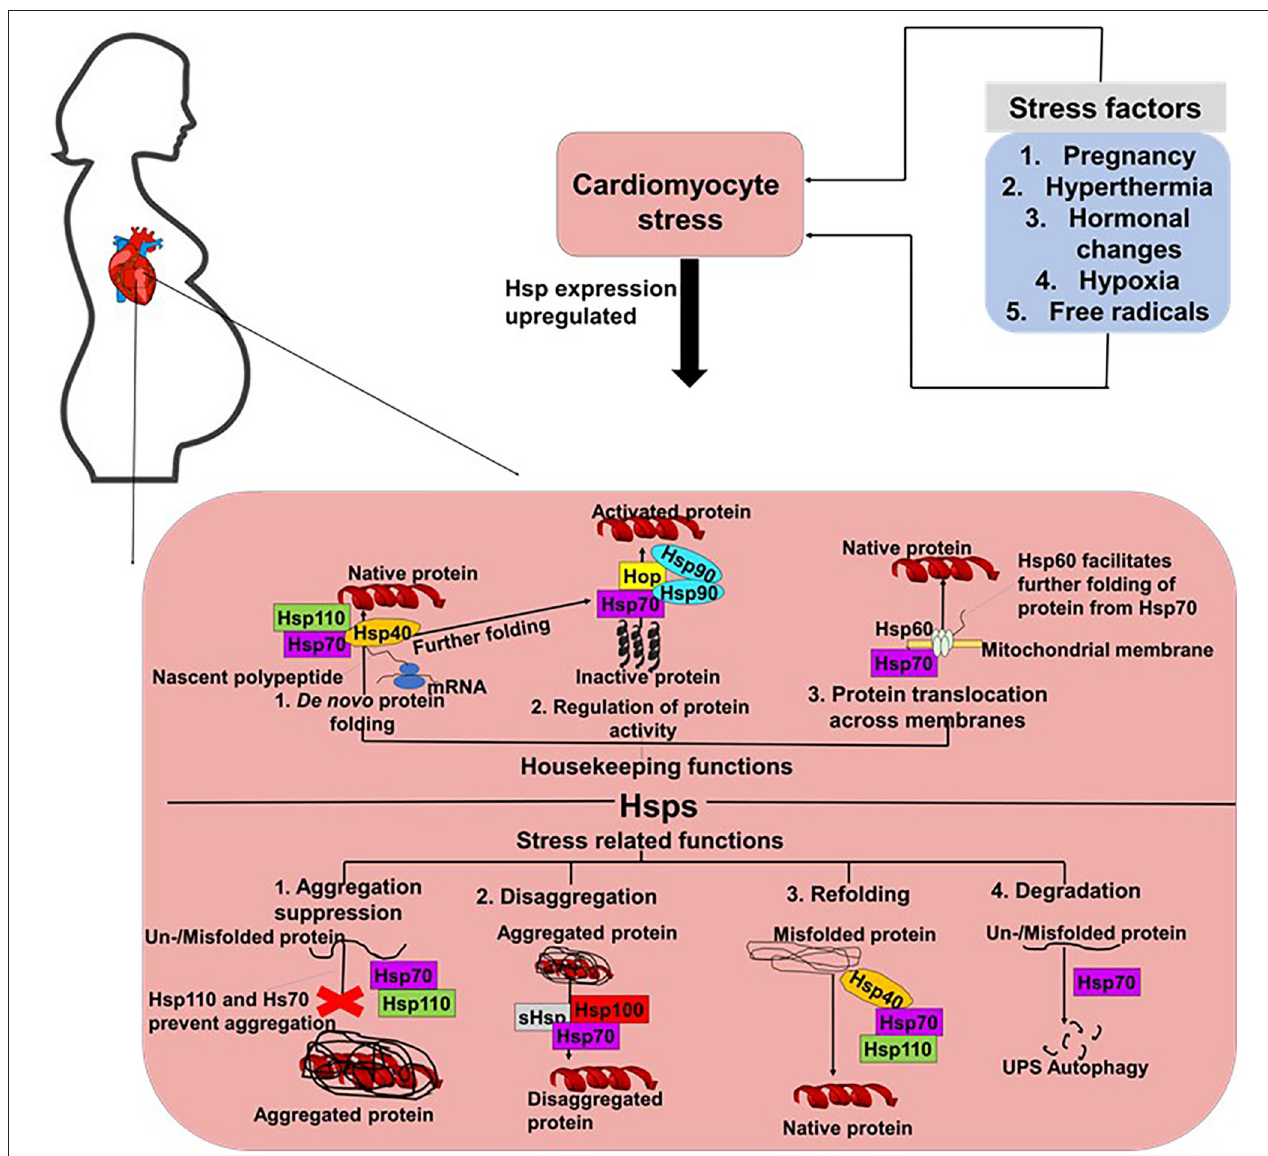
FIGURE 2 | Proposed roles of Hsps in PPCM. In cells, Hsp70s perform both housekeeping and stress response related roles. Hsp70s co-operate with various co-chaperones such as Hsp40 and Hsp110 to facilitate the de novo folding of polypeptides from the ribosome to facilitate their folding into their native conformations. Hsp70s also co-operate with Hsp90 and Hop to activate proteins. Hsp70s also form partnerships with Hsp60 to facilitate the translocation of proteins across membranes. Under stress conditions, Hsp70s prevent the formation of aggregates and also facilitate the degradation of misfolded/unfolded